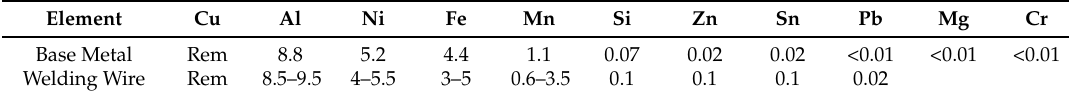
Table 2. Welding parameters of three tests.